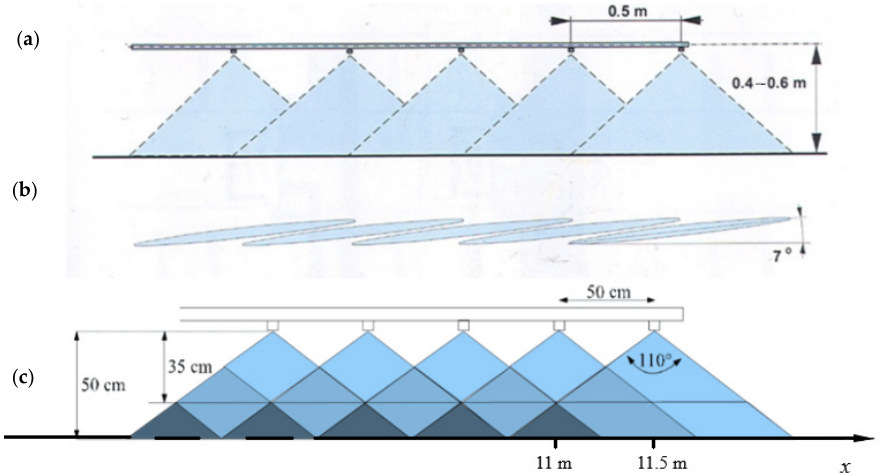
Figure 1. Formation of the transverse distribution of the sprayed liquid obtained from the boom of a field sprayer utilising flat fan sprayers: ( a ) streams viewed from the side; ( b ) streams viewed from above; ( c ) combining the streams of individual nozzles.